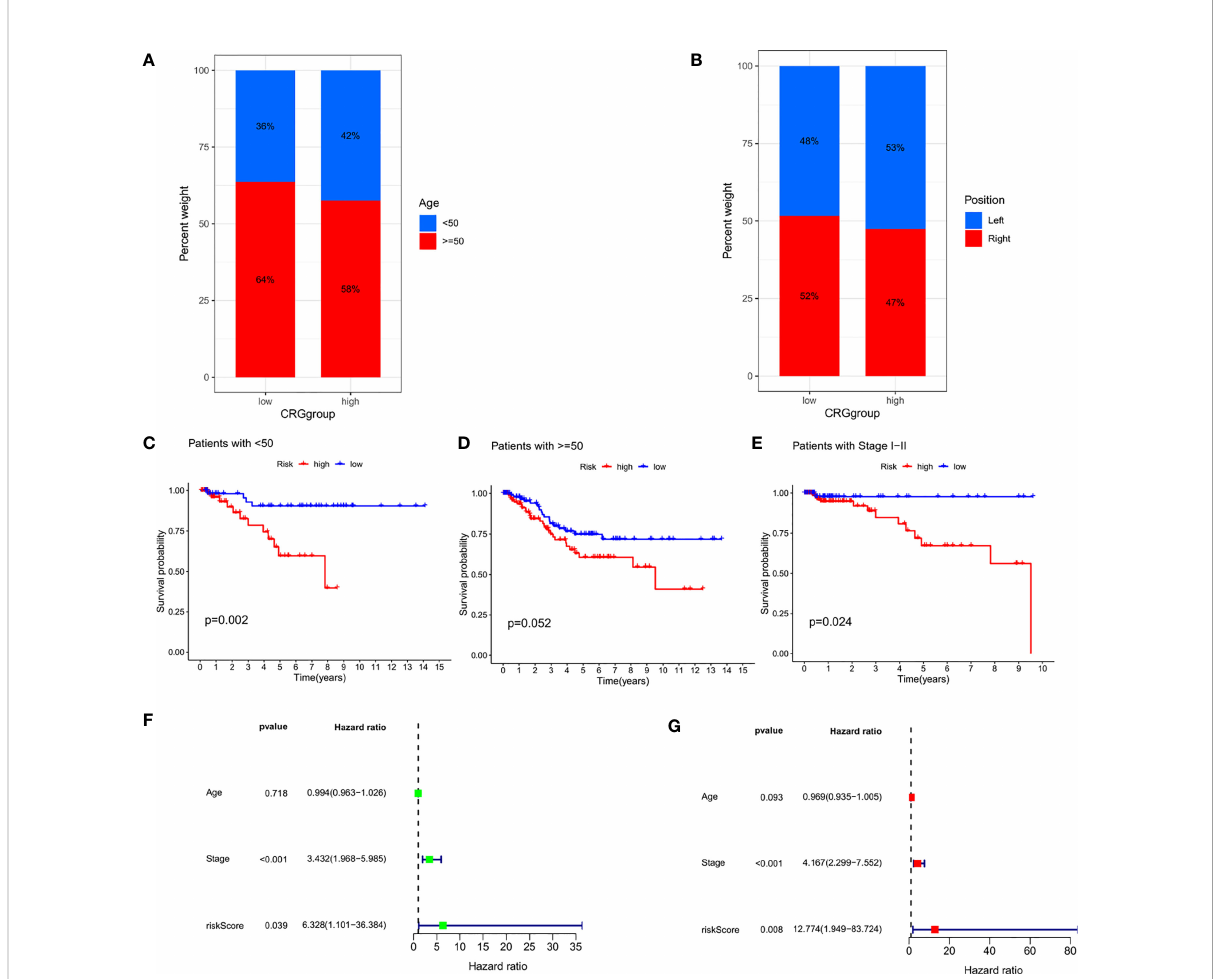
FIGURE 7 Independence detection of the constructed risk prediction model (A) Relationships between CRG_score and Age. (B) Relationships between CRG_score and Position. (C – E) Kaplan – Meier survival curves of survival probability prognostic value strati fi ed by age and stage. (F, G) Uni- and multi-Cox analyses of clinical factors and risk score with